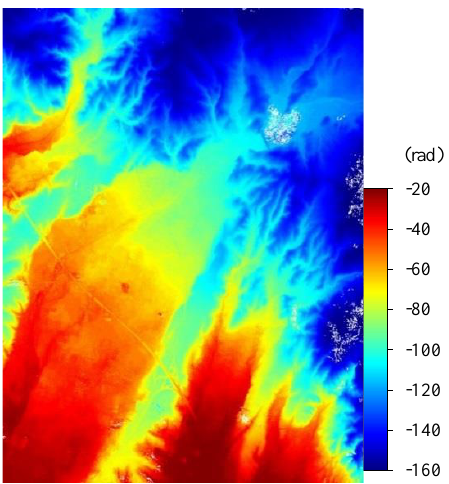
Figure 10. Phase unwrapping results with the minimum cost flow method.